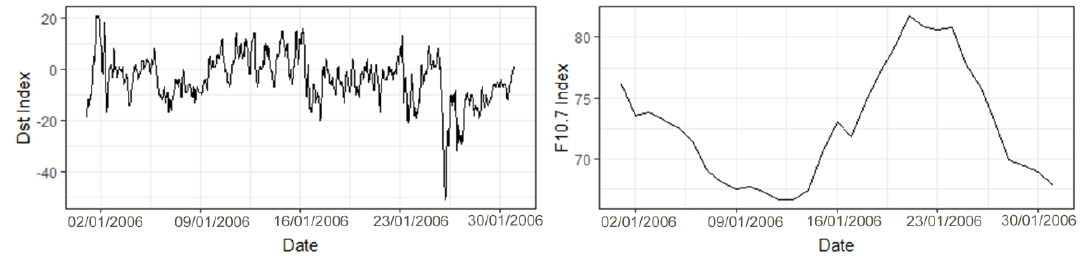
Figure 2. Geomagnetic index Dst and solar activity index F10.7 in January